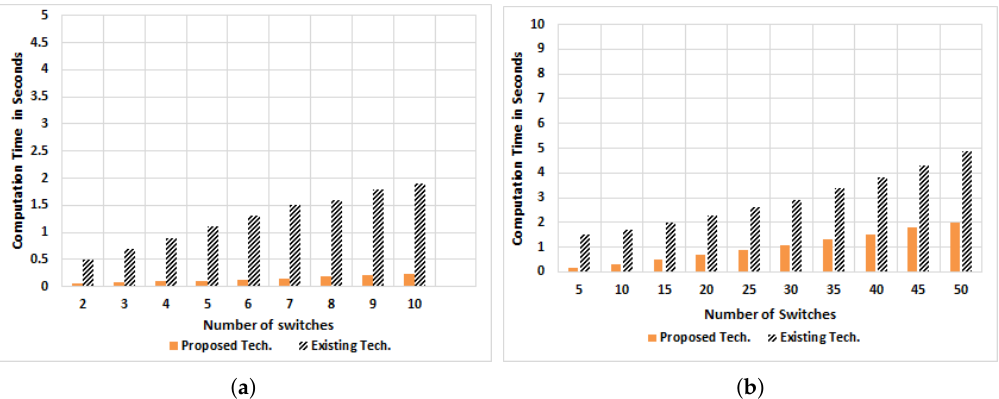
Figure 17. Simulation results of proposed and existing approaches for Graph Computation Time. ( a ) Computation Time when the Number of switches is varying and the number of policies is constant; ( b ) Computation Time when Number of switches is varying and number of policies is